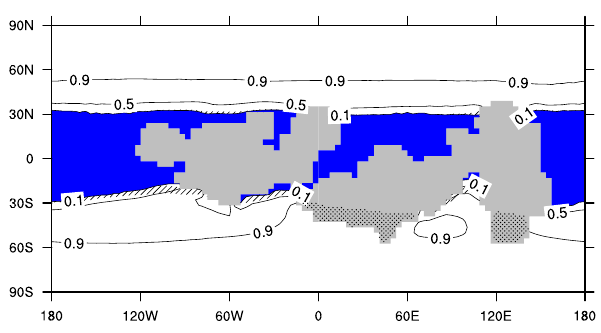
Fig. 6. Sea-ice fraction of simulation TSI96 averaged over years 6000 to 6199. Contour spacing is 0.4. Open water, defined by sea-ice fraction below 0.1 for this plot, is shown in blue. Areas with snow cover on sea-ice below 0.01m water equivalent depth are shaded. Continental areas with snow cover above 0.01m water equivalent are